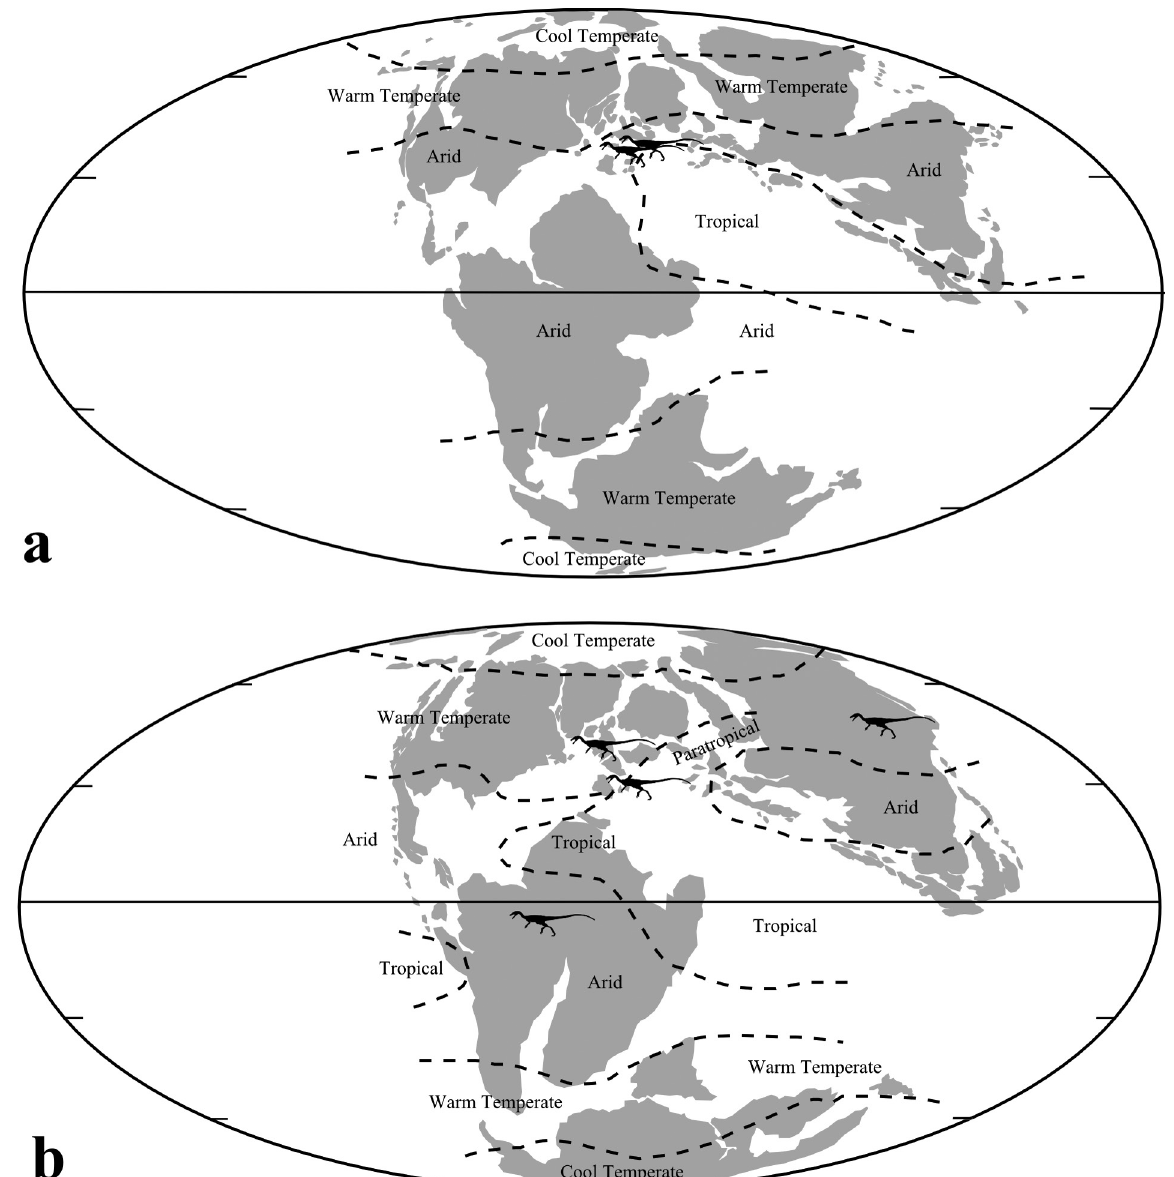
Fig. 1 - Paleogeographic maps of (a) Late Jurassic and (b) Early Cretaceous times showing the geographical distribution of compsognathids. The areas of occurrence are signalized with compsognathid body icons. Because of the proximity, the occurences within the same country were indicated with only one body icon. Body icons were modified from Naish et al. (2004), while the maps from Blakey (2006) are after Scotese